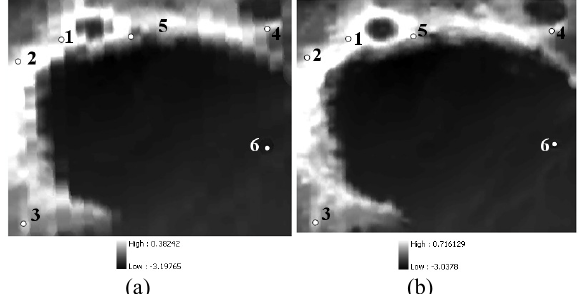
Figure 4. The 2D grey-scale images from Chang’E-1 laser altimetry data (a) and SELENE laser altimetry data (b) with the same 360-m resolution